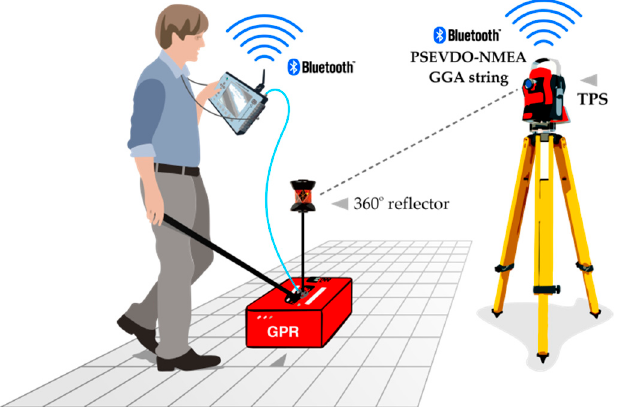
Figure 6. Sketch of the established terrestrial acquisition system of the kinematic GPR-TPS model process. Self-TPS combined with a GPR equipped with a 360° reflector used with a Bluetooth real-time connection.